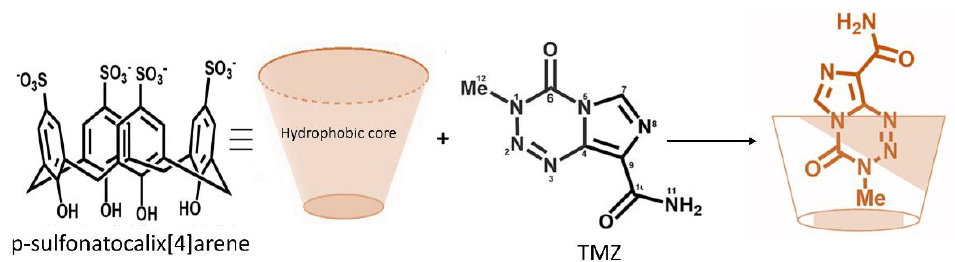
Figure 4. Schematic representation of TMZ encapsulated in the p -sulfonatocalix [4] arene macromolecule. The hydrophobic core of p -sulfonatocalix [4] arene interact and protect the methyl group of TMZ.